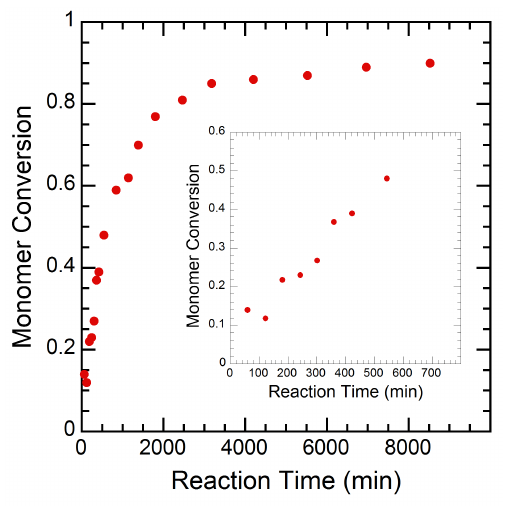
Figure A3. Polymerization kinetics (monomer conversion) of PMMA-2 as determined by 1 H NMR. The inset window highlights magnified early reaction time results.